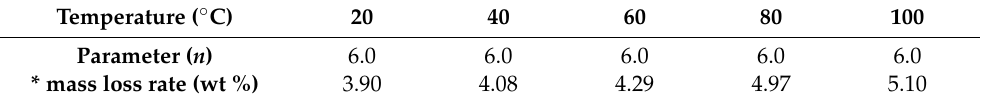
Table 2. Mass loss rates of MF 6 in the acid-treatment reaction at the different treatment temperatures. Temperature ( ◦ C) 20 Parameter ( n